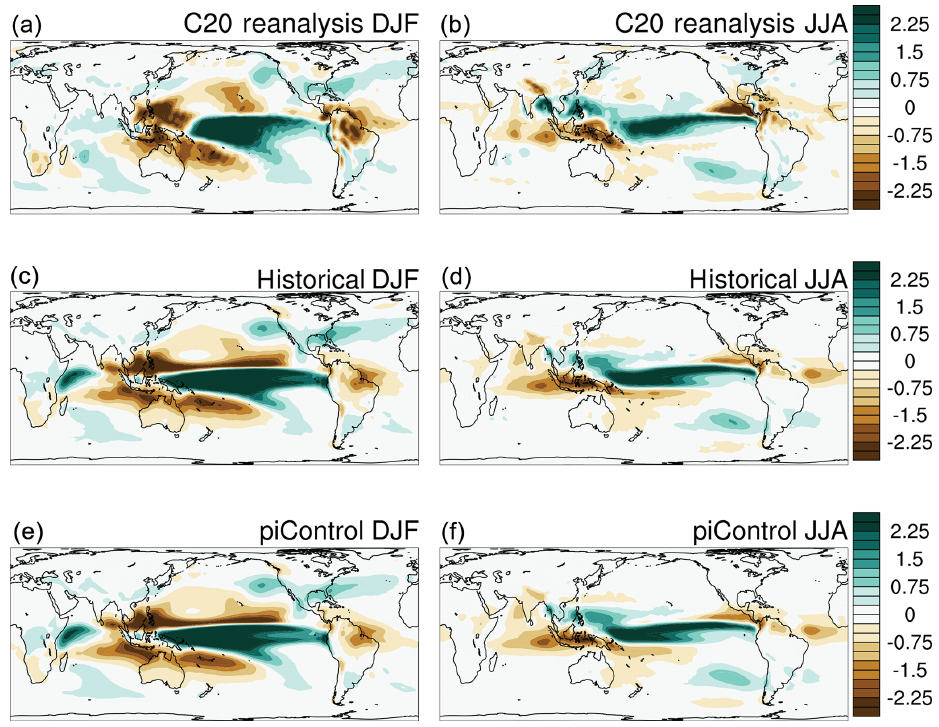
Figure 5. Evaluation of the ENSO precipitation teleconnections. Composite El Niño minus La Niña precipitation anomaly from (a) DJF and (b) JJA from the C20 reanalysis (Compo et al., 2011) between 1871 and 2010, (c) DJF and (d) JJA model ensemble mean from the historical simulations between 1850 and 2005 (CMIP5)/2015 (CMIP6), and (e) DJF and (f) JJA model ensemble mean from the pre-industrial control simulations. Units are mmd − 1 . Table 2. Multi-model mean change in ENSO amplitude (%) based on NINO3.4 standard deviation for each experiment relative to the pre- industrial control for all models, CMIP5/PMIP3 models, and CMIP6/PMIP4 models. Note that CMIP5/PMIP3 does not include lig127k experiment. Values in brackets for all models are the minimum and maximum model values. All models’